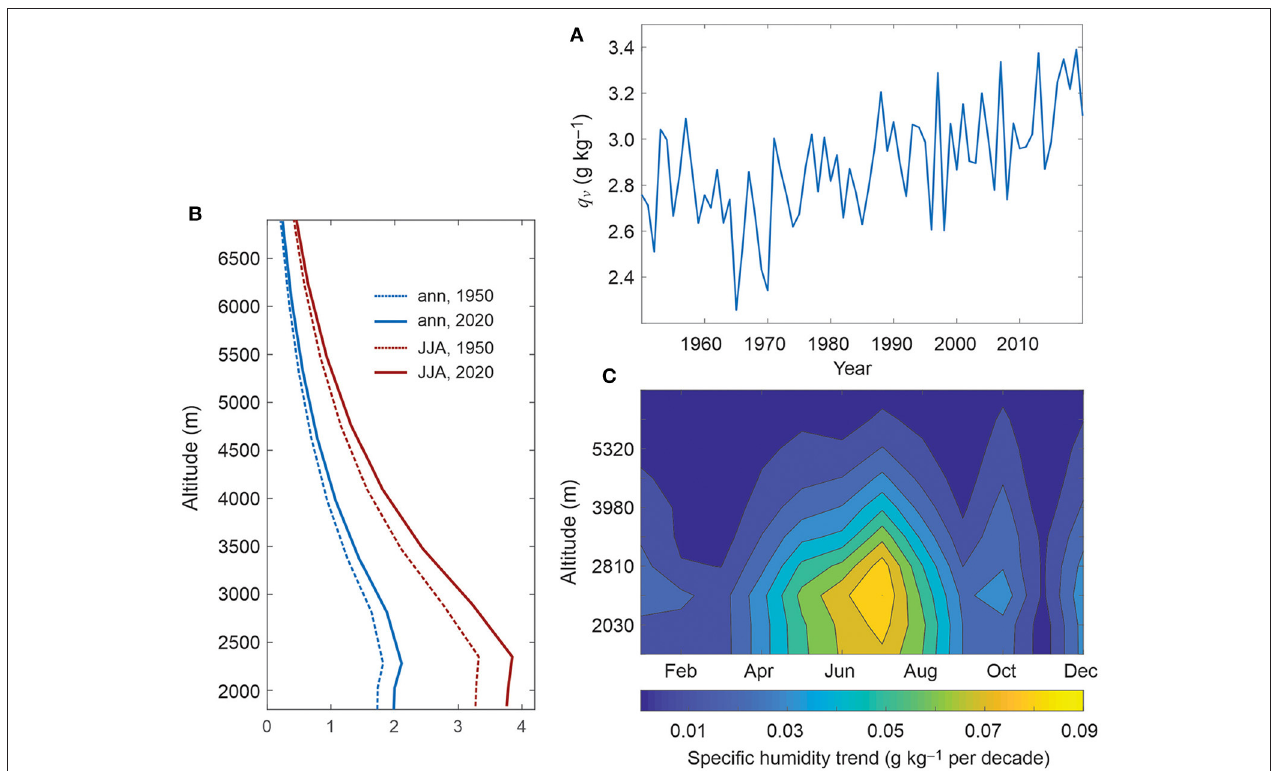
FIGURE 10 | Specific humidity evolution from 1950 to 2020 in the ERA5 climate reanalysis in the grid cell over the upper Kaskawulsh Glacier, St. Elias Mountains, Yukon. (A) Mean annual specific humidity at the 700-mb level ( ∼ 2,810m). (B) Profiles of mean annual and summer (JJA) specific humidity in the 1950s (dashed lines) and the 2010s (solid lines). (C) Specific humidity trends over the period 1950–2020 as a function of pressure-level (altitude) and